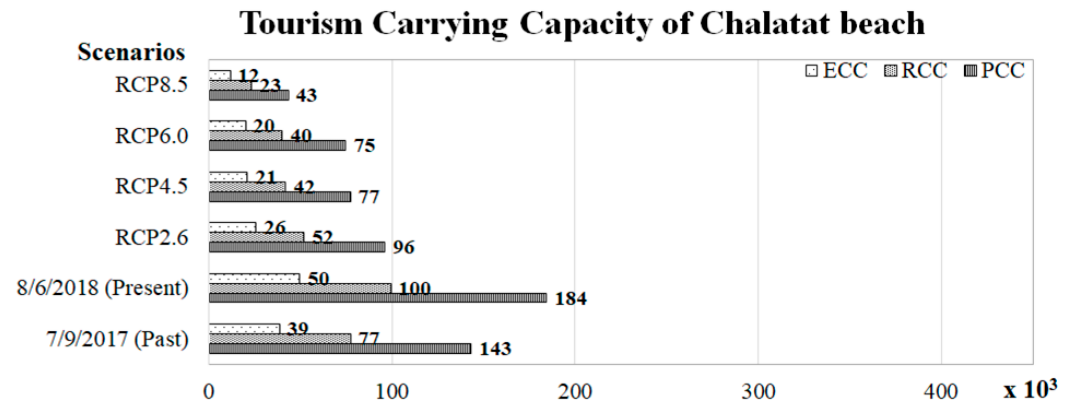
Figure 8. Tourism carrying capacity (TCC) of Pattaya beach.